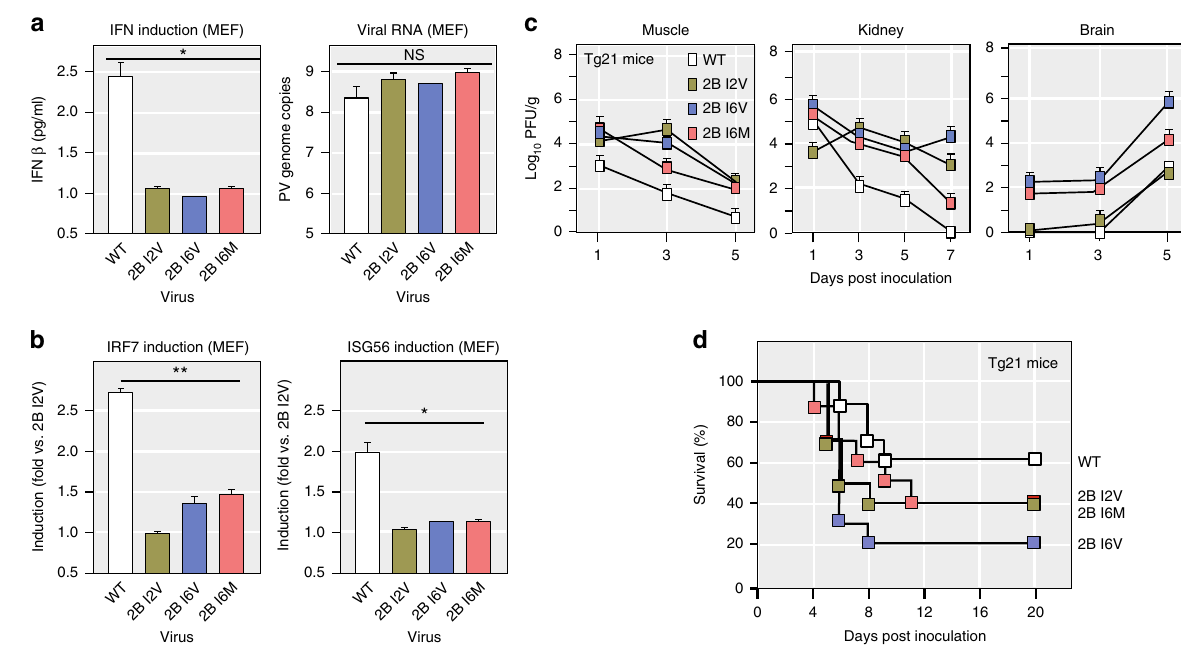
Fig. 6 Adaptive 2B mutants increased virus replication and pathogenesis immune-competent mice. a , b The adaptive 2B mutants induce less IFN response in primary murine embryo fi broblast cells (MEFs). a MEFs were infected with WT and 2B mutants at m.o.i = 0.1. supernatant was collected to measure IFN β by ELISA at 72 h postinfection. RNA copy number of poliovirus genome was measured by qRT-PCR on MEFs at postinfection 72 h. b mRNA expression level of IRF7 and ISG56 was measured by qRT-PCR on MEFs at postinfection 72 h ( n = 3, three replicates for each time, for each viral strain. Student ’ s t -test). n.s. indicates P > 0.05; * P ≤ 0.05, ** P ≤ 0.01. c Virus tissue distribution. Viral titers in kidney, muscle and brain of Tg21 mice inoculated with 10 6 PFU of WT, 2B I2V, 2B I6V, and 2B I6M administered I.P. route. Data were presented as logarithm(mean ± s.d.), PFU per ml. n = 4, the number of the mice is four per time point per viral strain. Limited detection level is 20 PFU per gram tissue. d Survival curve of Tg21 mice Tg21 mice were injected with 10 7 PFU WT, 2B I2V, 2B I6V, or 2B I6M administered by I.P. route. ( n = 10, the number of the mice is ten per